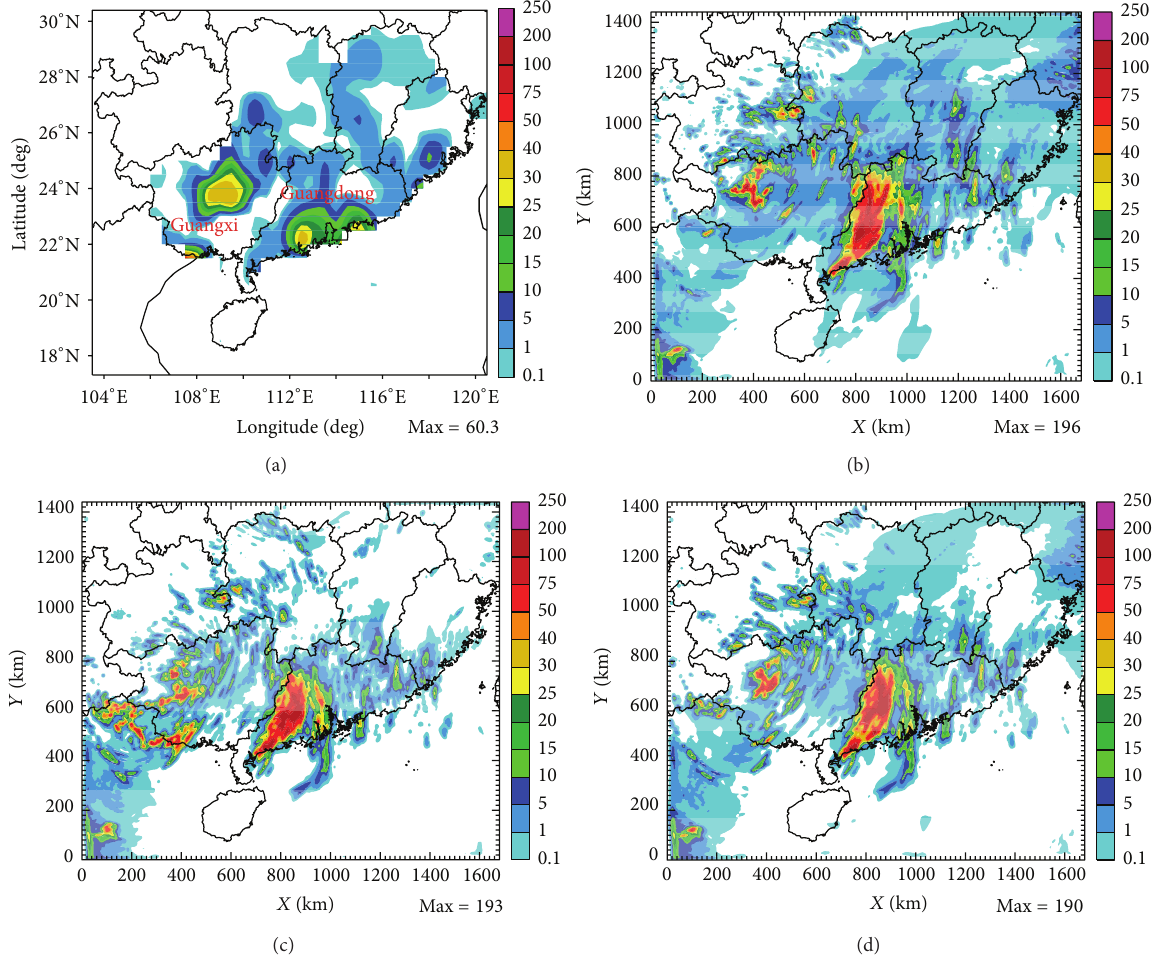
Figure 5: 6h accumulated precipitation from (a) observations, (b) CNTL, (c) RADSND, and (d) ALLDATA between 1200 and 1800 UTC June 29, 2011 for case 20110629.